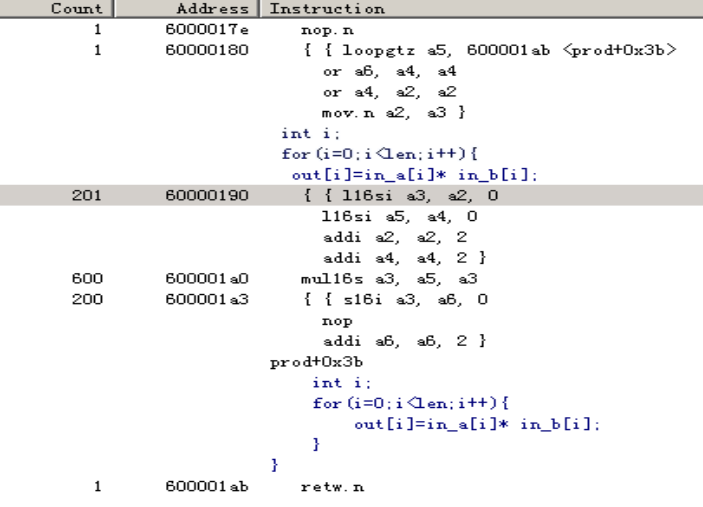
Figure 7. Cycle count statistics of dot product of two one-dimensional vectors without vectorization.